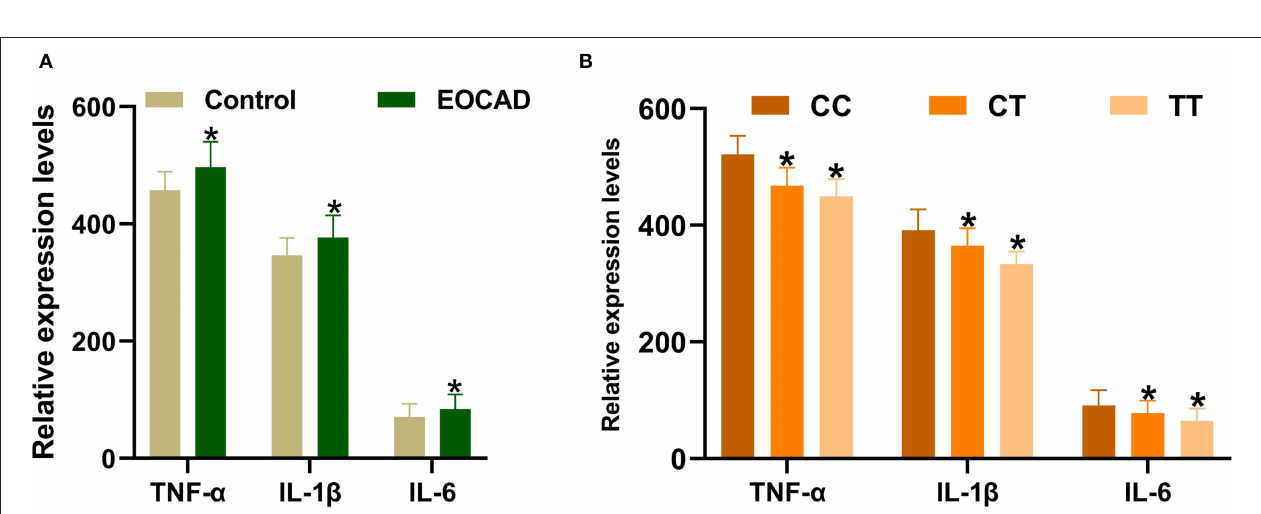
FIGURE 4 | The expression levels of the USF1 mRNA in the control and EOCAD groups. (A) USF1 expression levels were significantly higher in the EOCAD group than in the control group. (B) The rs3737787T allele carriers maintained lower expression levels of the USF1 mRNA than T non-carriers. USF1 , upstream transcription factor 1; EOCAD, early-onset coronary artery disease. * p < 0.01.